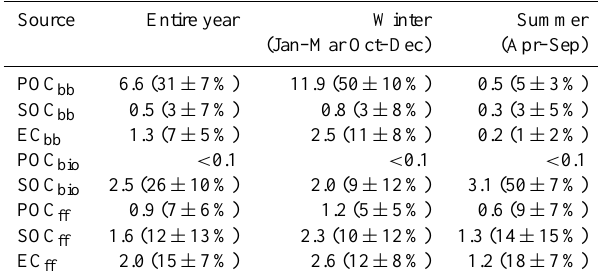
Table 4. Annual and seasonal average carbon concentrations (in µgm − 3 ) of the Quasi Monte Carlo best estimate results, and corre- sponding fraction of carbon mass between